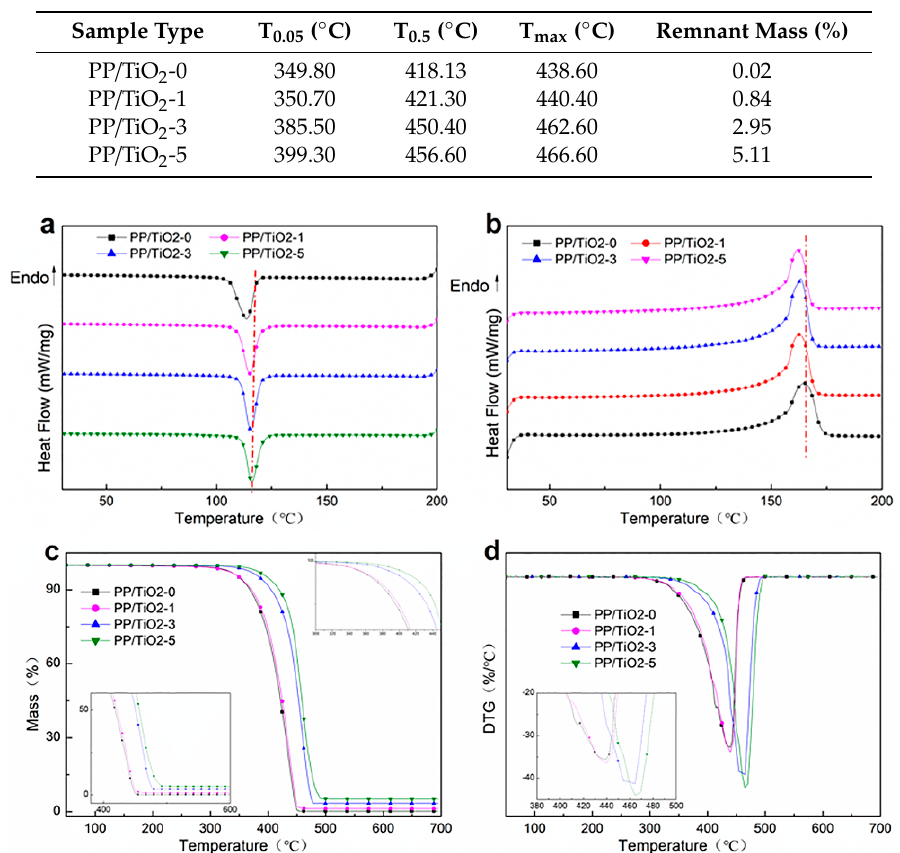
Figure 2. Thermal properties of PP / TiO 2 master batch. ( a ) DSC thermograms of first cooling processes; ( b ) DSC thermograms of second heating; ( c ) TG curves of PP / TiO 2 ; ( d ) DTG curves of PP / TiO 2 .